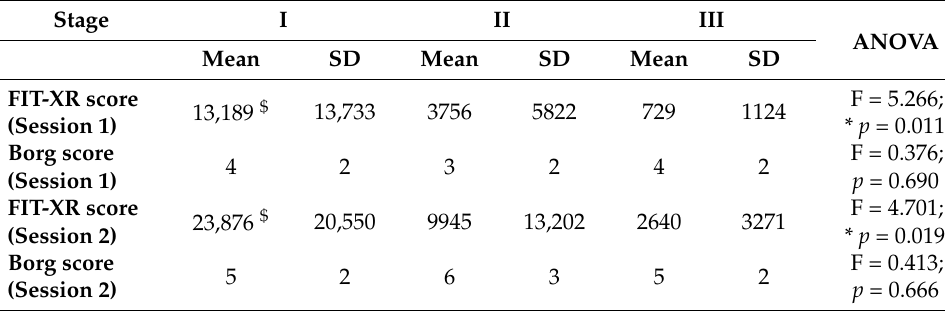
Table 4. Relationship between disease stage and VRI task